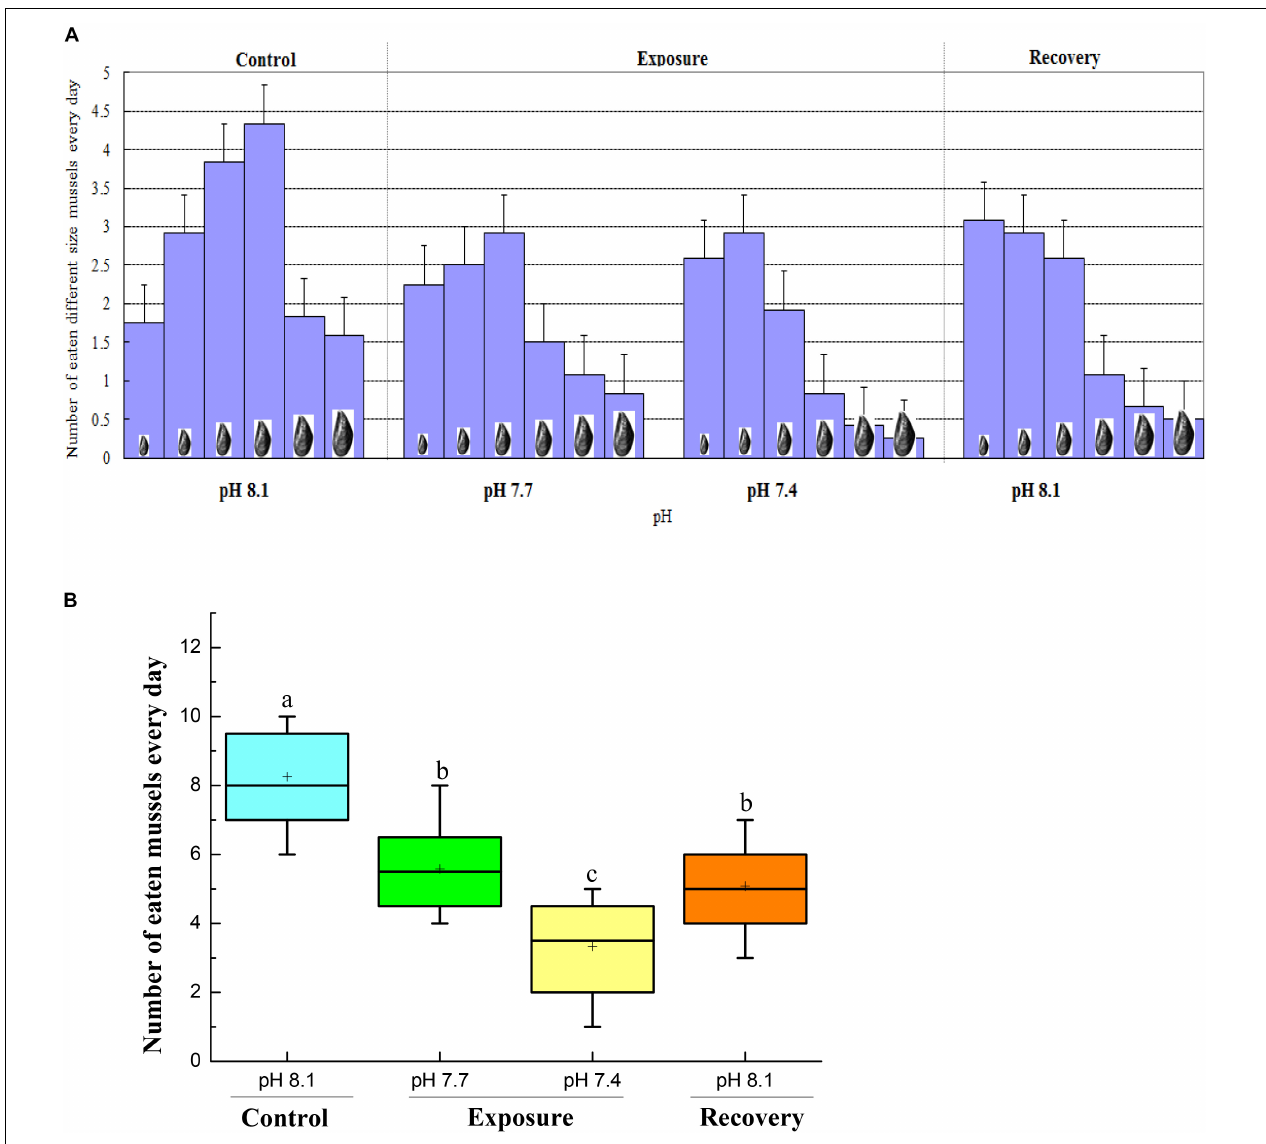
FIGURE 4 | Prey-size selection (A) and feeding rate of same-sized mussels (41–50 mm) (B) of C. pagurus at different pH conditions. Values are mean consumption rates ± SE ( n = 12) expressed as number of eaten Mytilus edulis crab − 1 d − 1 . Increased triangles denote increased mussel size, from small to big, shell length ranged from 10–20, 21–30, 31–40, 41–50, 51–60, 61–70 mm. Different letters indicate significant differences compared to initial control pH conditions ( P <